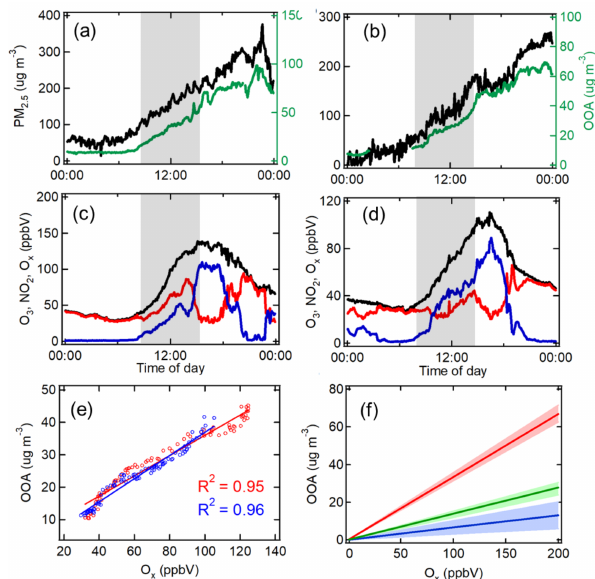
Figure 3. Temporal evolutions of measured PM 2 . 5 (black) and OOA (green) mass concentrations (a, b) and O 3 (blue), NO 2 (red), and O x (black) mixing ratios (c, d) during the early stages of the two haze episodes. Panels (a) and (c) are for the episode starting on 27 September 2013, and (b) and (d) are for the episode starting on 4 October 2013. Panel (e) represents linear regression between O x and OOA on 27 September (red circles) and 4 October (blue circles) 2013. The grey shadings (a–d) correspond to the largest variation in O x , which covers both the clean and transition peri- ods. Panel (f) corresponds to the ratios of [OOA] changes to [O x ] changes ( (cid:49) [OOA] /(cid:49) [O x ]) for Beijing (red), Mexico City (green), and Houston (blue). The ratios for Beijing are derived from this study, and the ratios for Mexico City and Houston taken from Wood et al. (2010). Color shadings in (f) represent the range between the minimum and maximum ratios.